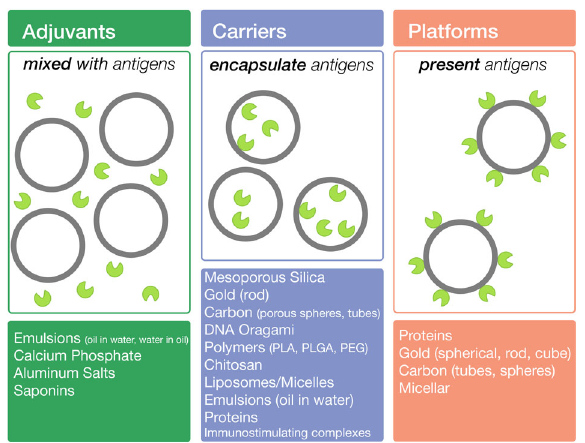
Fig. 1 The three categories of nanoparticle roles in vaccines as adjuvants, carriers, and platforms with the descriptions of the role below. Gray circles represent nanoparticles while, green circular indented units represent antigens. Abbreviations PLA, PLGA, and PEG correspond to polylactic acid, polylactic-co-glycolic acid, and polyethylene glycol, respectively. Modi fi ed and adapted from Zhao et al. 2 .